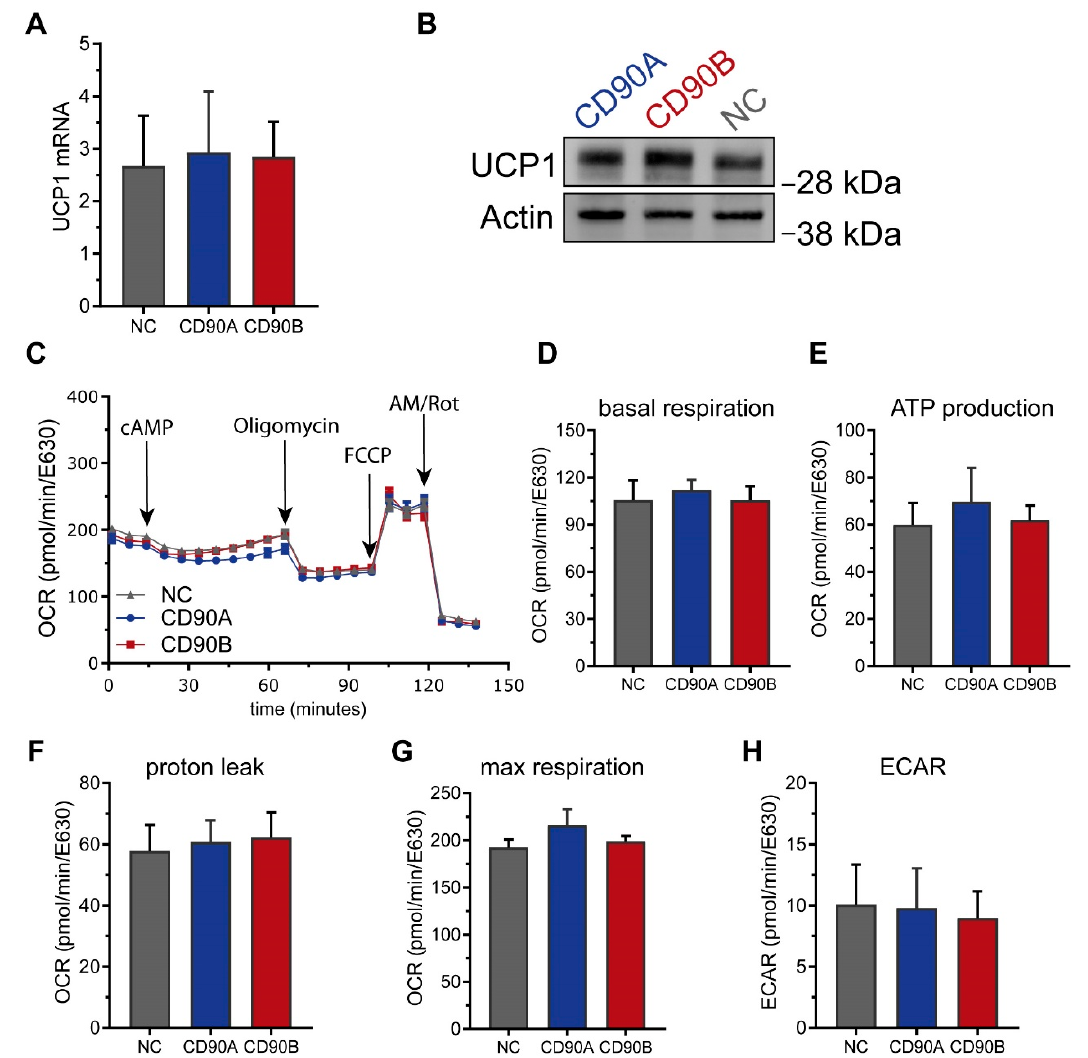
Figure 6. CD90 knockout has no impact on the adipocyte phenotype in human SGBS cells. CD90-deficient (CD90A and CD90B) and control (NC sgRNA) SGBS were subjected to adipogenic differentiation. ( A ) UCP1 mRNA expression was determined by RT-qPCR. TF2B expression was used to normalize the data. Data are displayed as mean ± SEM of 3 independent experiments. ( B ) UCP1 protein expression was determined by Western blot. β -actin was used as a loading control. A representative experiment out of 3 independent experiments is shown. ( C–H ) Cells were analyzed using Seahorse technology to determine the oxygen consumption rates (OCR). ( C ) Representative trace, ( D ) basal respiration, ( E ) ATP production, ( F ) proton leak respiration, ( G ) maximal respiration, and ( H ) extracellular acidification rate were determined as described in Methods. Data are displayed as mean ± SEM of 3 independent experiments. No significant differences between groups were detected by one-way ANOVA with Tukey correction.